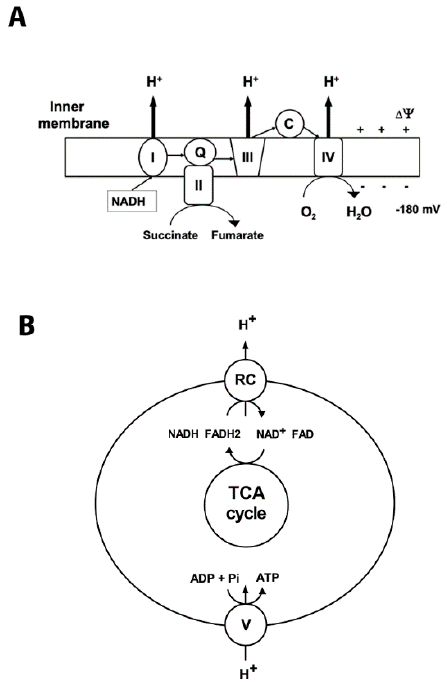
Figure 1. Mitochondrial oxidative phosphorylation. Oxidative phosphorylation generates ATP using the electrochemical potential (comprised of chemical gradient of hydrogen ions and the membrane potential ∆ 03A8) formed by the respiratory chain complexes in the inner mitochondrial membrane. ( A ) Complex I (NADH: ubiquinone oxidoreductase (I)) accepts electrons from NADH, and together with complex II (succinate: ubiquinone oxidoreductase (II)), which oxidizes succinate to fumarate, transfers electrons to ubiquinone (Q). Then the electrons are accepted by complex III (III) and transferred to complex IV (IV) via cytochrome C (C). At complex IV oxygen is reduced to water. Respiratory chain (RC) complexes I, III, and IV pump hydrogen ions (H + ) across the inner membrane to generate the protomotive force that drives complex V to synthetize ATP. The thin arrows represent the transfer of the electrons; bold arrows show the hydrogen ions’ transport across the inner membrane. ( B ) Schematic illustration of coupling between activity of respiratory complexes (RC) and ATP production by complex V (ATP